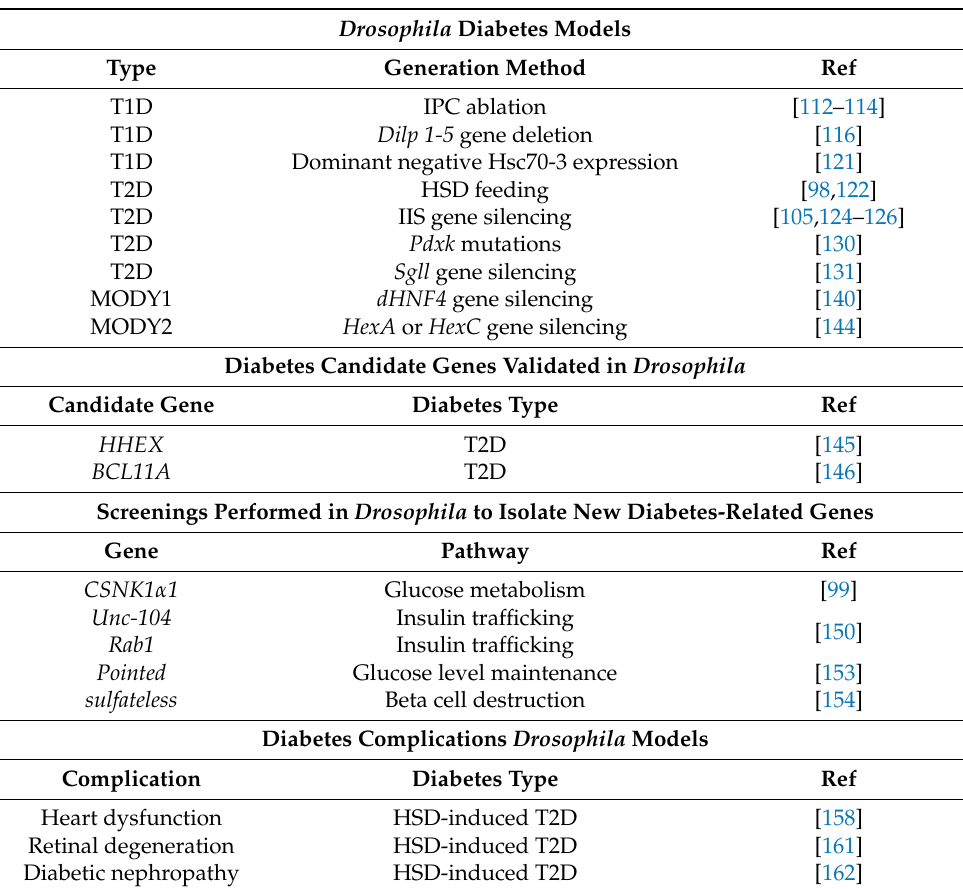
Table 2. Schematization of the different exploited approaches to study diabetes using Drosophila as an experimental